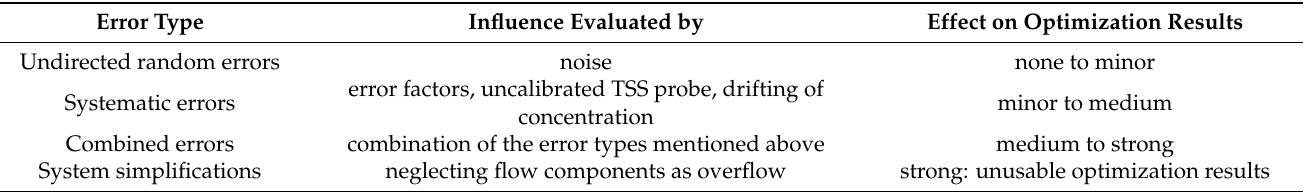
Table 3. Influence of different measurement errors on data-based optimization